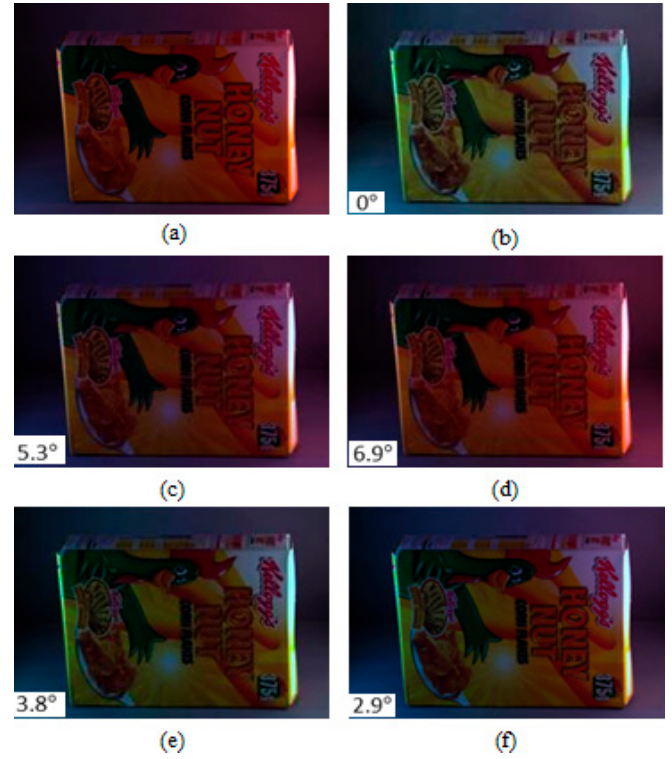
Figure 6. Original, ground truth and its colour-balanced images using different colour correction methods: ( a ) Original image from the MLS dataset [32], ( b ) Ground truth image, ( c ) Grey Edge-2, ( d ) Weighted Grey Edge, ( e ) Gisenji et al. and ( f ) Proposed CCAFIS methods’ images. To generate the Mean Opinion Score (MOS) for the images of the proposed and the state-of-the- art colour constancy methods, a set of images from the Grey Ball, the Colour Checker and the MIMO image datasets, which contain images of scenes lit by either single or multiple light sources, was chosen. The selected images were colour-corrected using the proposed CCAFIS method, as well as other state-of-the art techniques including the multiple illuminant methods such as: Gijsenij et al. [32], MIRF [33] and Cheng et al. [38]. Ten independent observers subjectively evaluated the resulting colour-balanced images. The viewers scored the colour constancy of each image from 1 to 5, where higher numbers correspond to increased colour constancy. The average MOS of different methods’ images were then calculated and tabulated in Table 2. From Table 2, it can be noted that the proposed method’s images have the highest average MOS when compared to the other techniques’ images. This implies that the proposed method’s images have the uppermost subjective colour constancy. Table 2. Mean Opinion Score (MOS) of the proposed and the state-of-the-art techniques. Method Dataset (Number of Images)